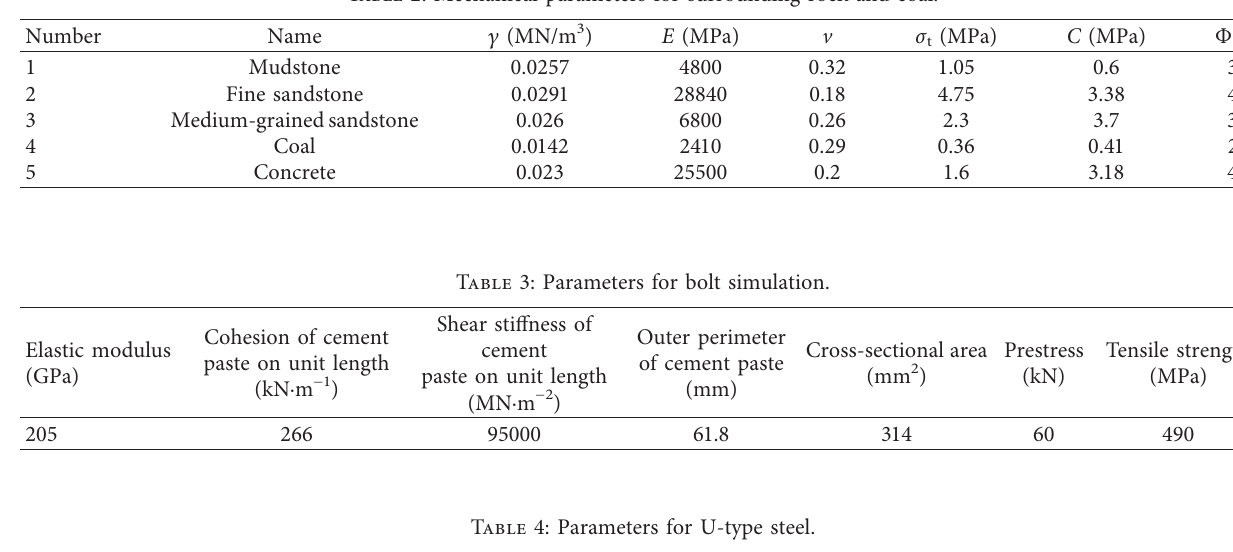
Table 2: Mechanical parameters for surrounding rock and coal.